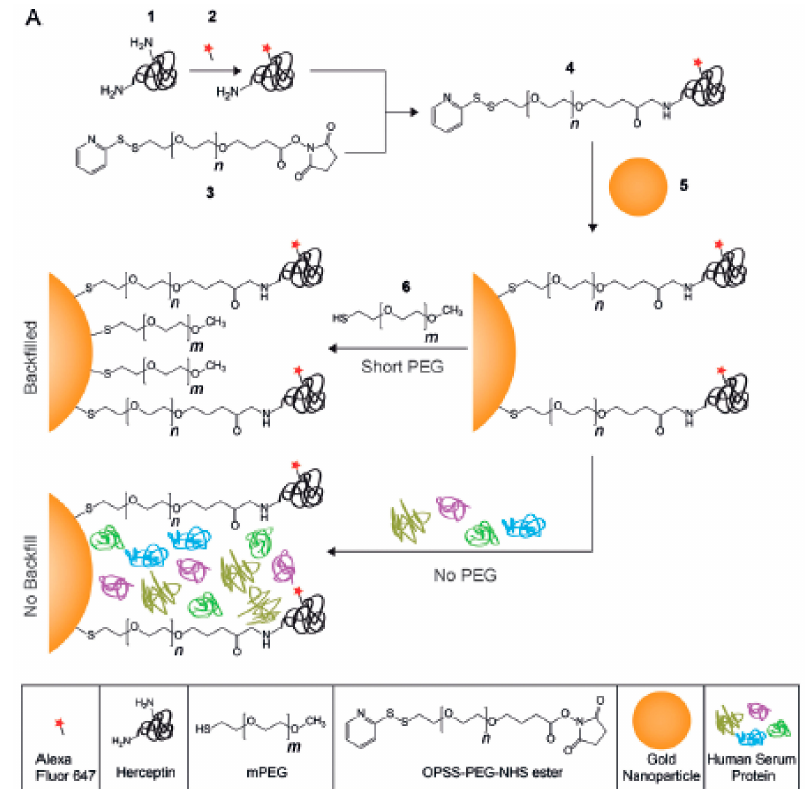
Figure 2. Polyethylene glycol (PEG) chains of di ff erent sizes are grafted to Au nanoparticles to generate high-density polymeric shells capable of avoiding the formation of the protein corona. Reprinted with permission from reference [38]. Copyright (2014)